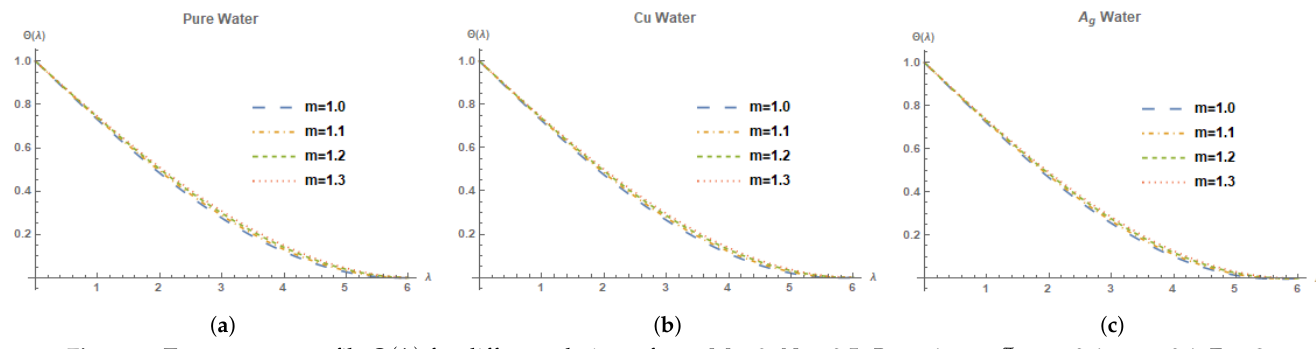
, τ = 0.6, η u = 0.1, Γ = 2, 6